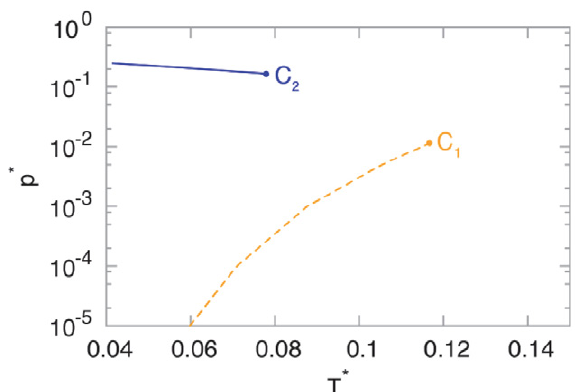
Figure 13: Phase diagram of the noncrystalline phases of water. Blue solid line is liquid-liquid and orange dashed line liquid-gas co- existence